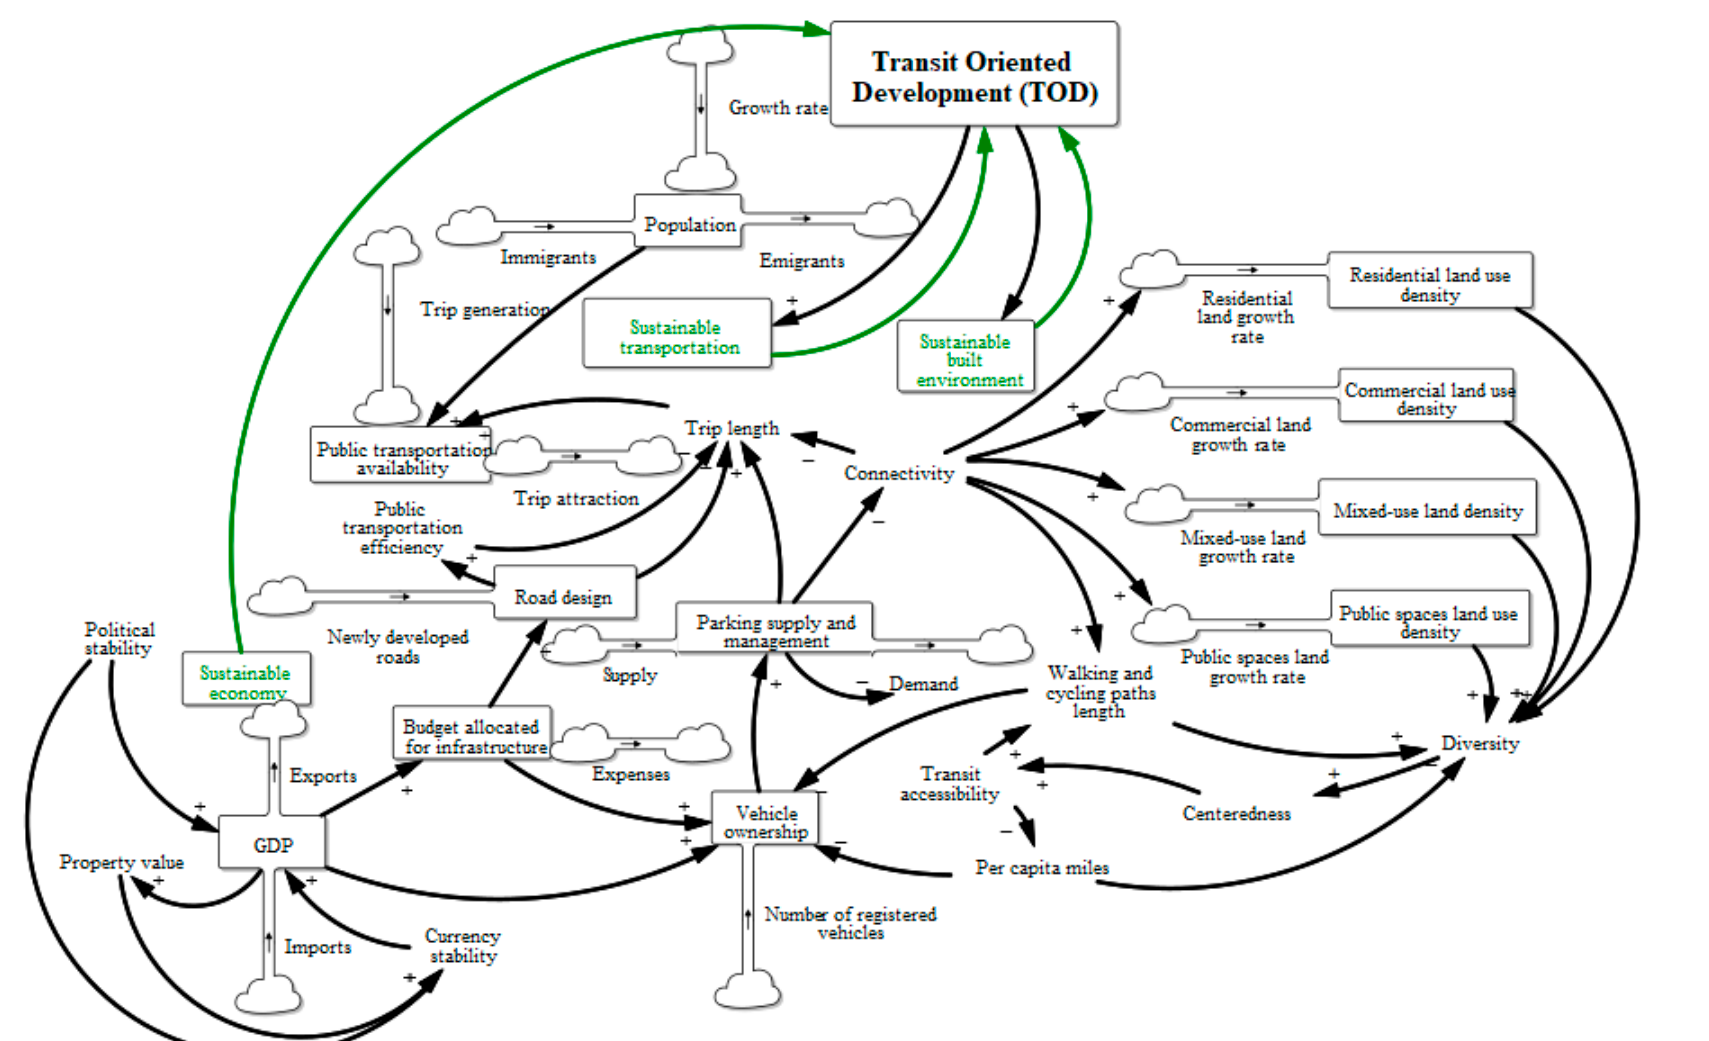
Figure 4. Stock and flow diagram (Source: the Authors).